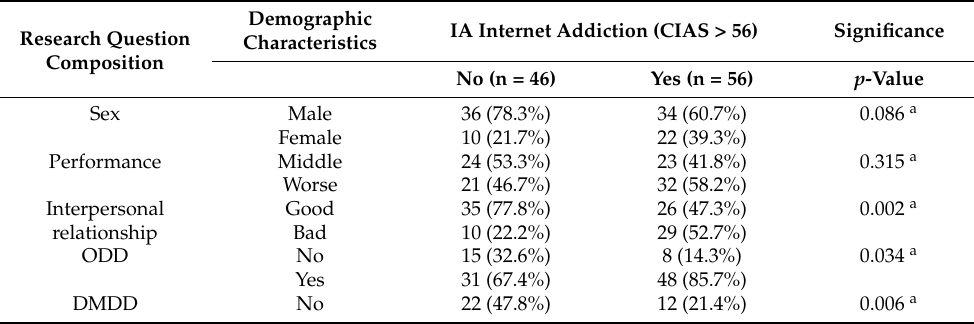
Table 1. The results of comparing the socio-demographic information of the current sample between Internet Addiction (IA) and